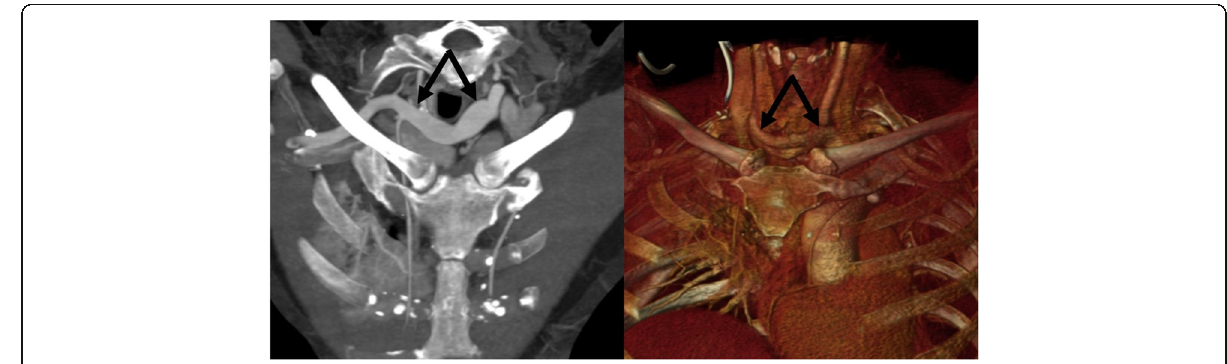
Fig. 9 High-riding truncus brachiocephalicus. MIP ( a ) and 3D volume rendering ( b ) reconstruction in an oblique frontal orientation depicting a high-riding truncus brachiocephalicus (arrows) in the lower neck coursing transverse in front of the trachea, high above the sternal manubrium